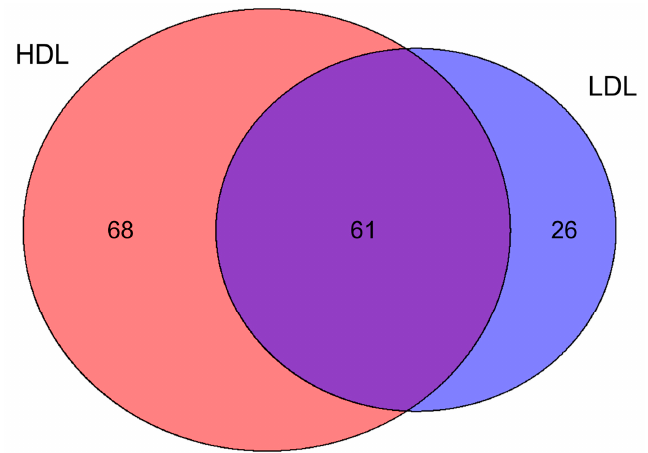
Figure 2. Venn diagram showing the distribution between HDL and LDL of the 155 proteins identified. The two lipoprotein fractions shared 61 proteins, whereas 68 and 26 proteins were exclusive to HDL and LDL, respectively.